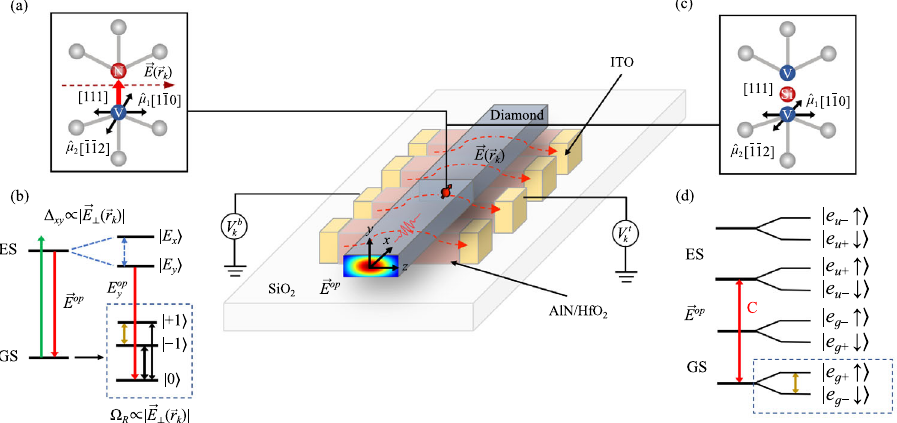
Fig. 1 | An exemplary FPSA implementation. A diamond waveguide (gray) containing CCs is positioned on an array of high-index dielectric fi ns (red) between ITO electrodes (yellow) connected to a voltage supply. Electric fi elds ~ E ð ~ r k Þ aregeneratedby top (bottom)contacts at potentials V The CC fl uorescence couples to the waveguide mode ~ E wg z . Here the ^ x = ½ 001 (cid:3) , ^ y = ½ 110 (cid:3) , ^ z = ½ 1 (cid:2) 10 (cid:3) . a The NV center in diamond in the [111] direction with transitiondipoles ~ μ 1 = ½ 1 (cid:2) 10 (cid:3) and ~ μ 2 = ½ (cid:2) 1 (cid:2) 12 (cid:3) . The FPSA fi eldiscloselyalignedto the ~ μ 1 transition, and perpendicular to the spin quantization axis. b A Zeeman shift in an